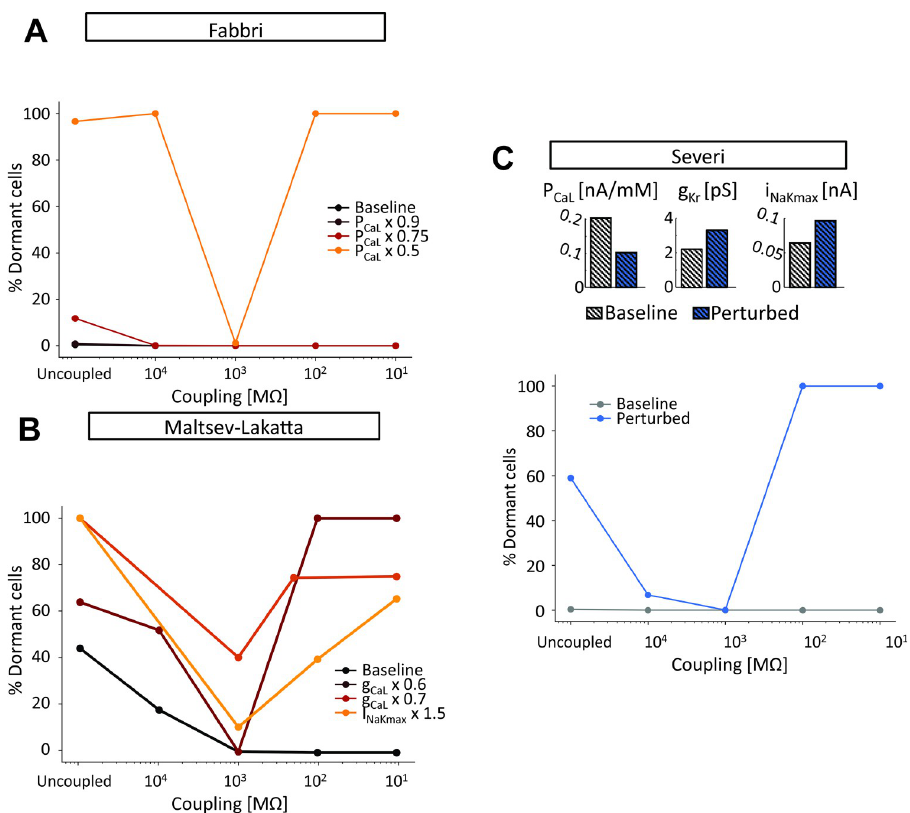
Fig 7. Pathophysiological changes in ionic currents lead to a pattern of tissue automaticity dependent on the degree of intercellular coupling. (A) Effect of L-type Ca 2+ current (I CaL ) perturbation in the Fabbri tissue model ( σ equal to 0.1). (B) Effect of perturbation in I CaL and Na + /K + pump (I NaK ) in the Maltsev-Lakatta tissue model ( σ equal to 0.4). (C) Effect of combined I CaL , rapid delayed rectifier K + current (I Kr ), and I NaK perturbation in the Severi tissue model ( σ equal to 0.2).